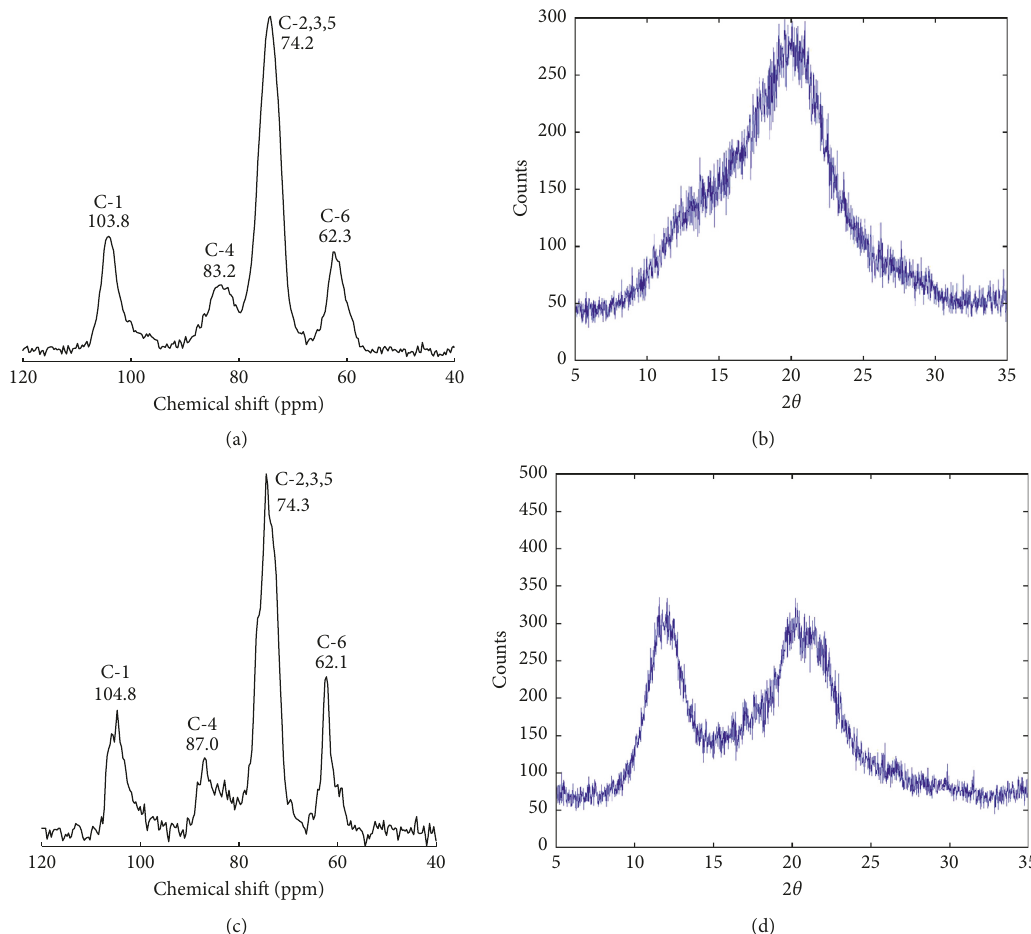
Figure 3: 13 C NMR spectra (a, c) and XRD diffractograms of fraction 1 regenerated with acetonitrile (a, b) and cellulose regenerated with water (c,